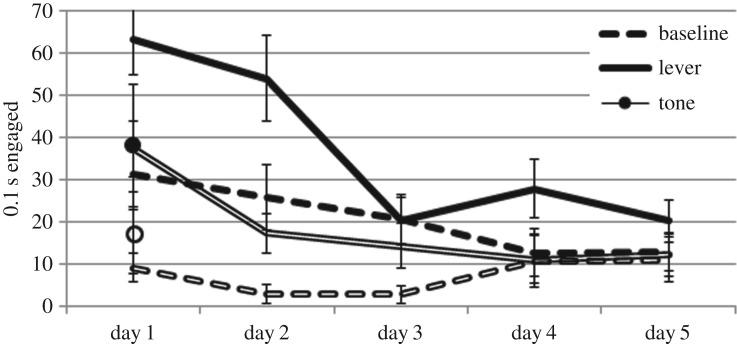
Presence on the feeder platform over the 5 days of extinction during lever presentations, tone presentations (first day only), and baseline recordings for group 75%+ (hollow lines) and group 25%+ (filled lines). Bars show s.e.m.